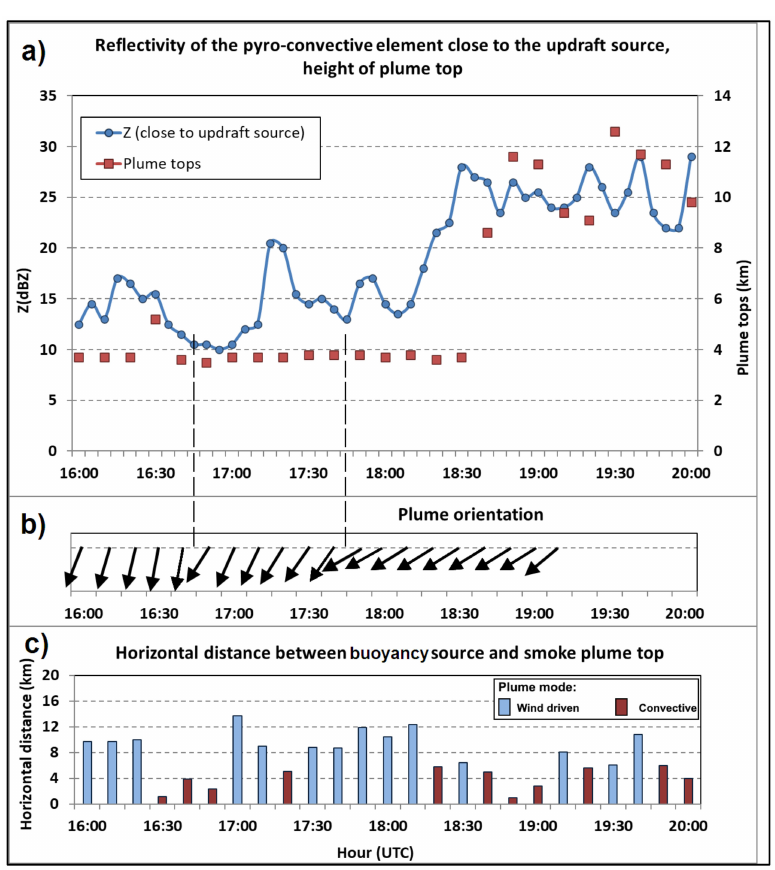
Figure 14. ( a ) Reflectivity of the pyroconvective element close to the updraft source (blue line). Plume tops (red squares) (16:00–20:00 UTC). ( b ) Plume orientation denoted by arrows that point downwind (16:00–19:10 UTC). Dashed-lines highlight orientation changes >= 20 ◦ . ( c ) Bars denote the horizontal distance between buoyancy source and smoke plume top (16:00–20:00 UTC). 17 June